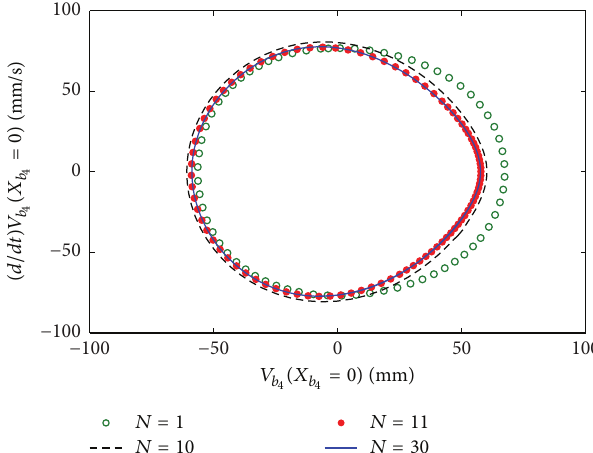
Figure11:Phaseportraitsoftheresponseofthemidpointofthedeck beam for different numbers of Galerkin truncation terms, 𝑞 𝑟 (0) = 0.1𝛿 1𝑟 .